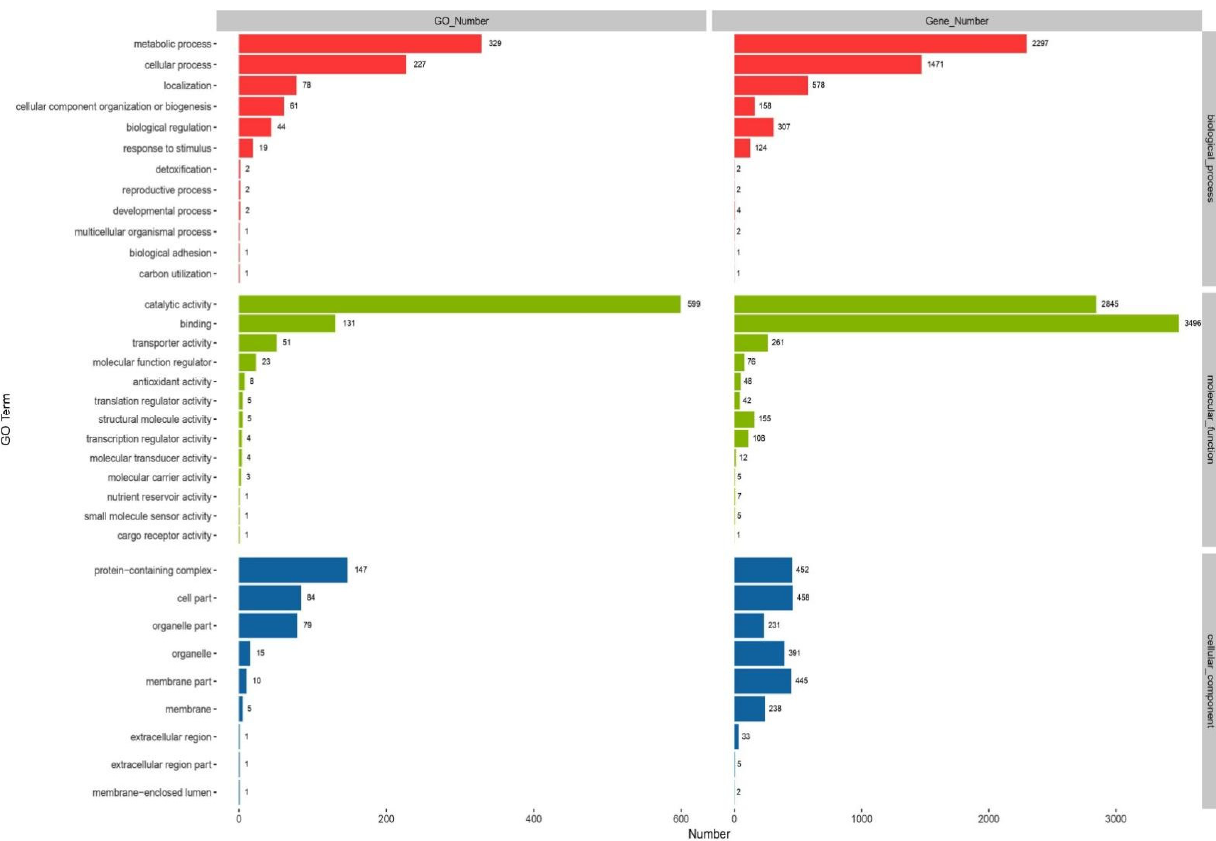
Figure 5. The Gene Ontology (GO) function annotation of C. unicolor SP02.